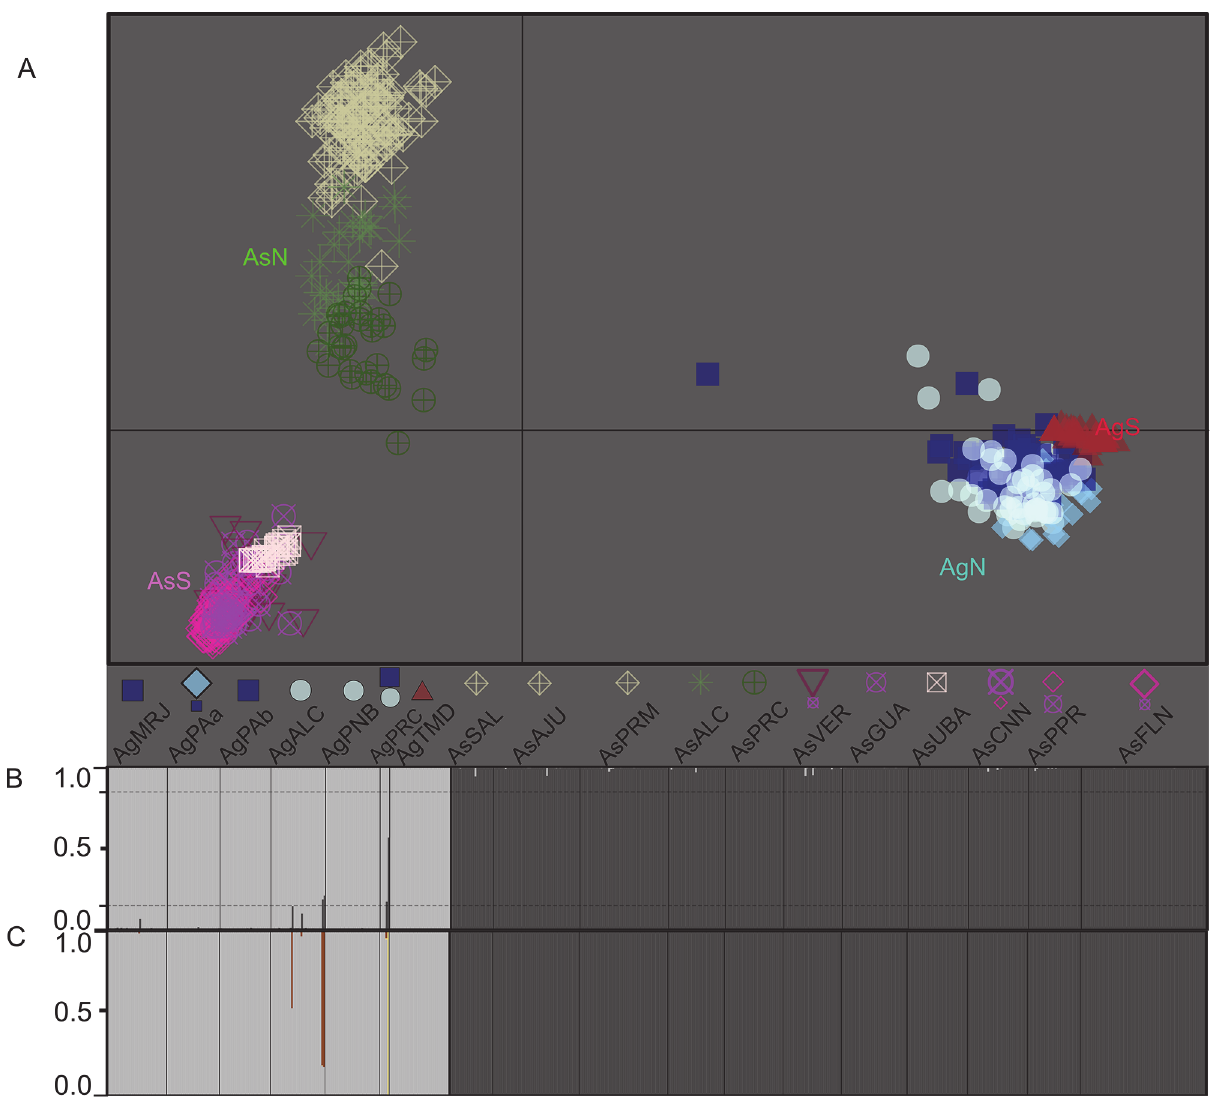
Fig 7. Analyses of ongoing hybridization between A . germinans and A . schaueriana . A) A scatterplot of the first two principal components of the multivariate analysis of DAPC [36]. Each symbol indicates the group to which each individual was assigned. The geographic origin of each individual is denoted for each locality sample such that more than 10% of the total number of individuals is composed of the inferred cluster. A larger symbol indicates that a cluster was predominant in the locality sample (pairwise cluster ratio larger than 1:5), whereas equal symbol sizes indicate similar cluster contributions to the total individuals of each sample. B) Model-based clustering analyses [38,39] considering k = 2, where each individual is represented by a vertical line and each color refers to one cluster; the posterior probability of group membership is indicated. The dashed horizontal lines denote the arbitrary threshold of 0.15, which was used as a sign of possible interspecific hybridization. C) Posterior probability of the model-based approach for identifying species hybrids [45]. Each vertical line also refers to an individual, and different colors indicate distinct classes of individuals: light gray: “ pure ” A . germinans ; dark gray: “ pure ” A . schaueriana ; dark orange: A . germinans second-generation backcrossed individuals; and yellow: F1 interspecific hybrid.